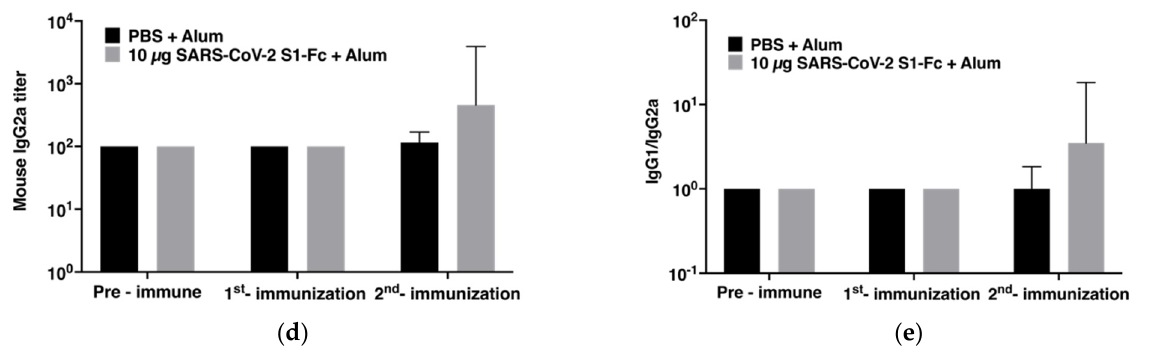
Figure 3. Mice immunogenicity studies. Diagrammatic illustration of immunization procedure and sample collection. Groups of mice ( n = 5) were immunized with 10 µg of SARS-CoV-2 S1-Fc protein adjuvanted with alum on days 0 and 21. Mice sera were obtained on days 0, 14, and 35 ( a ). Titers of SARS-CoV-2 RBD-specific mouse ( b ) total IgG, ( c ) IgG1, ( d ) IgG2a, and ( e ) the ratio of SARS-CoV-2 RBD-specific mouse IgG1/IgG2a titer at indicated time-point. Data presented as geometric mean ± 95% CI of the endpoint titers in each group, n = 5. Two-way ANOVA, Tukey test, was used (**: p < 0.01).